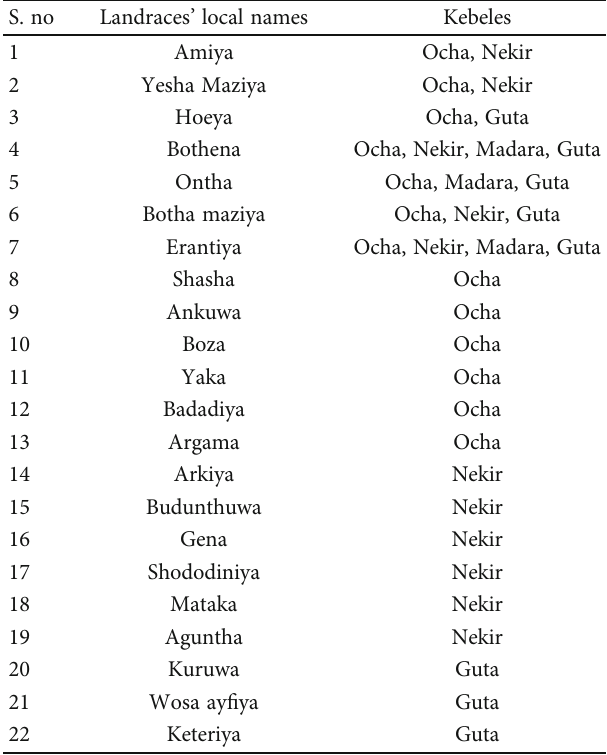
Table 3: The various enset